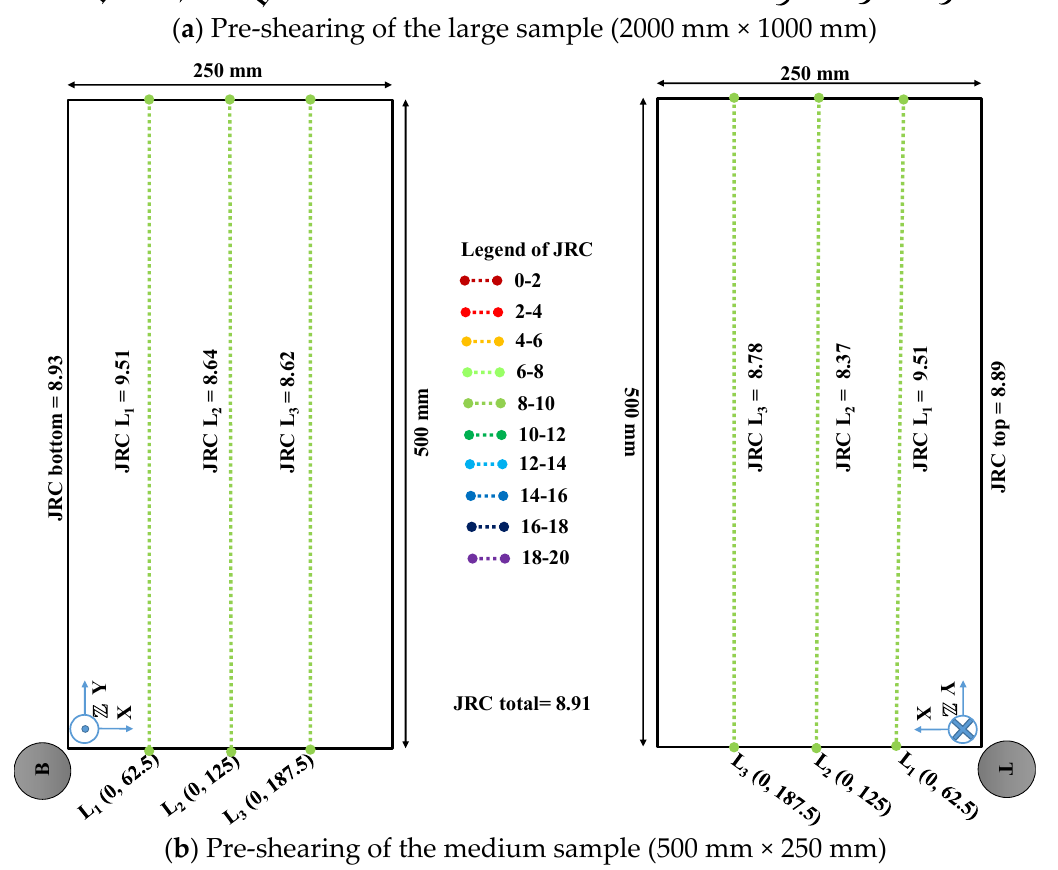
Figure 11. The photogrammetry method and Z ′ 2 to define the JRC roughness of the slabs ( a ) pre-shearing of the large sample (2000 mm × 1000 mm), ( b ) pre-shearing of the medium sample (500 mm × 250 mm).